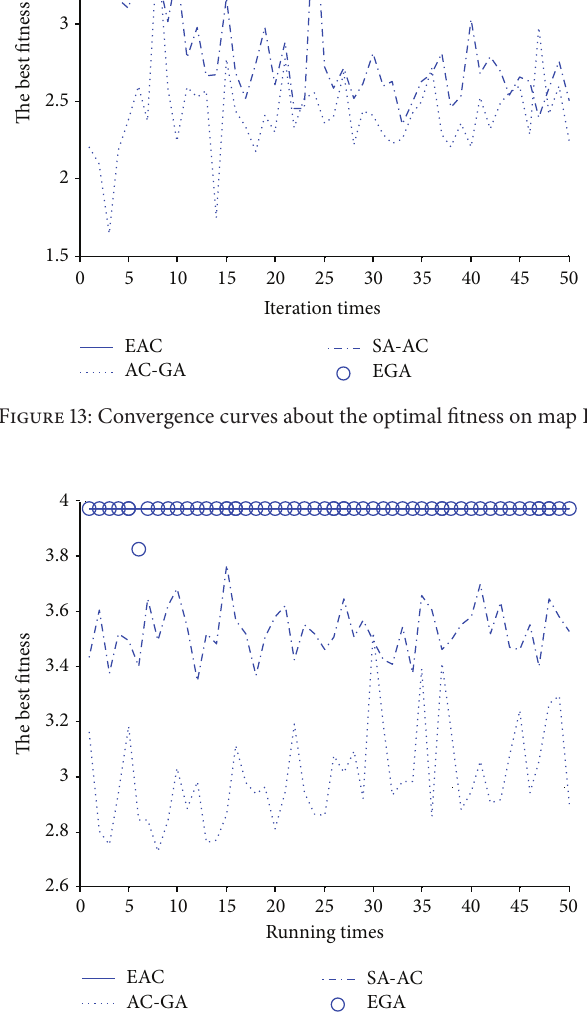
Figure 14: Convergence curves about the optimal fitness running 50 times on map I.